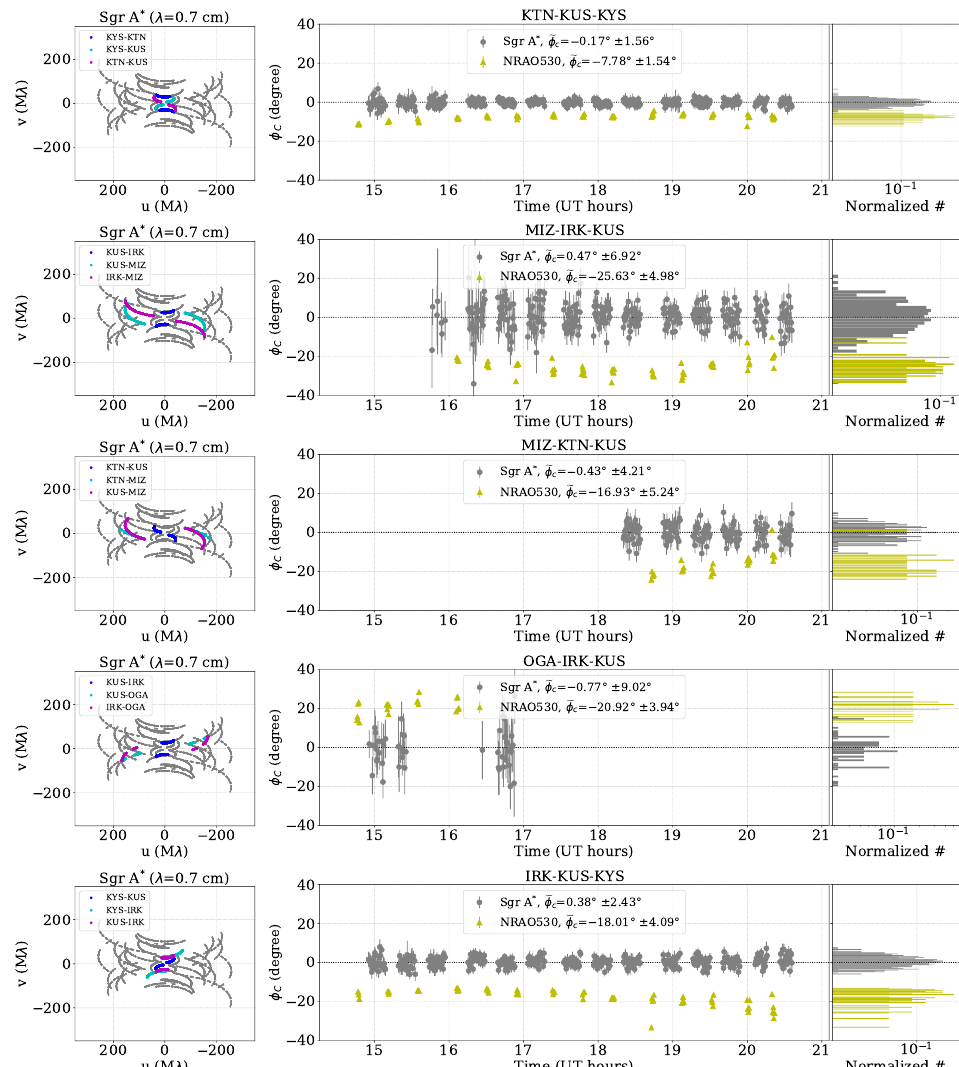
Figure 2. Closure phases of SgrA ∗ (gray) and NRAO 530 (yellow). From left to right, the corre- sponding baselines toward SgrA ∗ in the u − v plane (colored points), closure phases as a function of observing time, and a histogram of the closure phases are shown. The 30s averaged are shown, and the error bar represents the quadratic sum of the thermal noises (i.e., without the fractional systematic error) over the visibility amplitudes. The time-averaged closure phase, (cid:101) φ c , is shown in each legend, together with the uncertainty from the standard